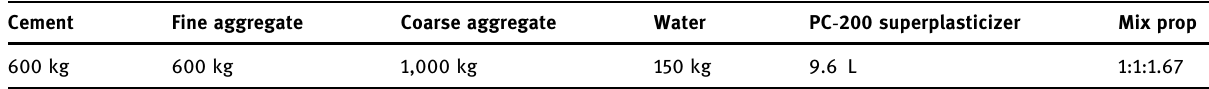
Table 2: Modi fi ed mix details ( with PC superplasticizer )